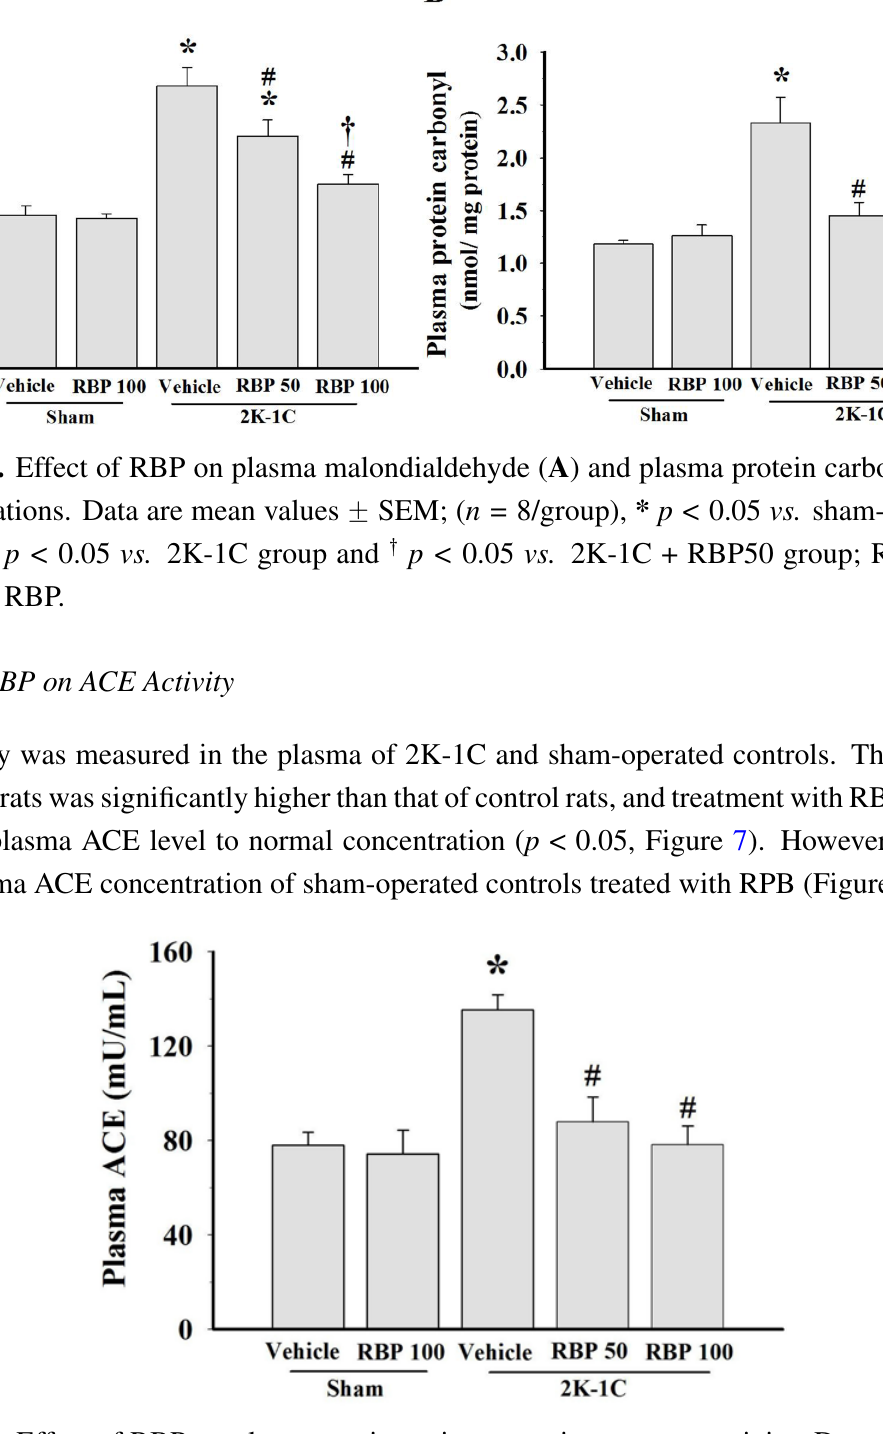
Figure 7. Effect of RBP on plasma angiotensin converting enzyme activity. Data are mean values ± SEM; ( n = 8/group), * p < 0.05 vs. sham-operated group, # p < 0.05 vs. 2K-1C group; Rice bran peptides, RBP.